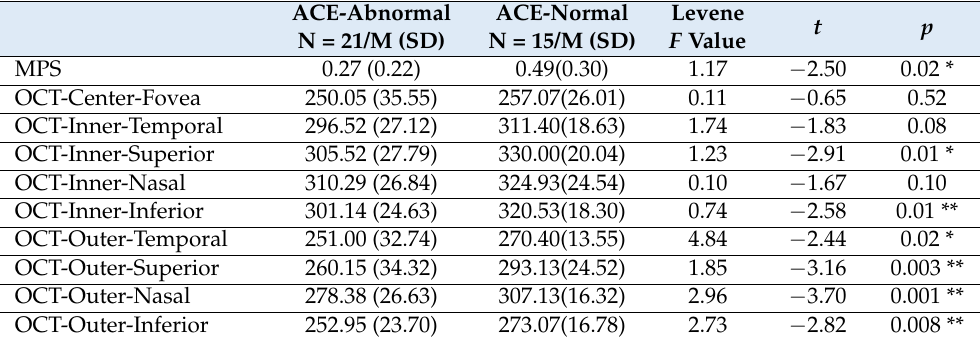
Table 2. Independent t -test of ocular physiology between ACE-normal and -abnormal subjects.